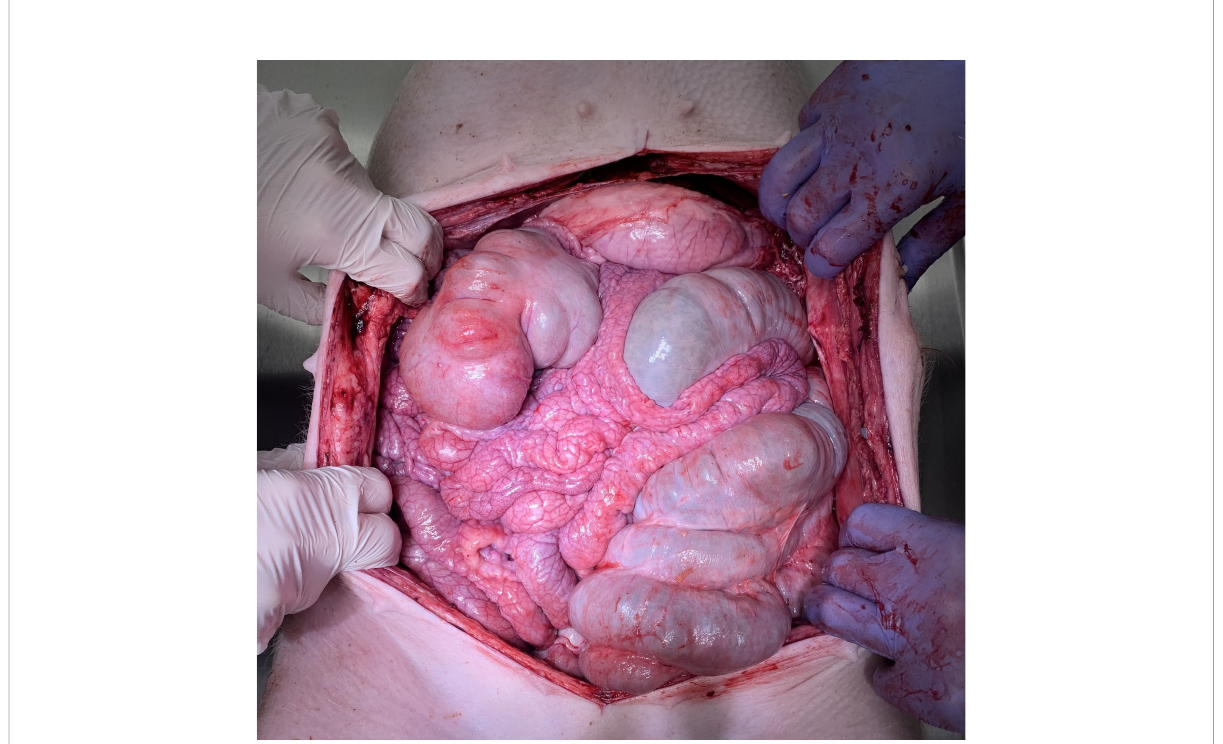
FIGURE 5 Macroscopic view during postoperative autopsy (day 7). No indication of perforation, adhesions or ascites within the abdominal